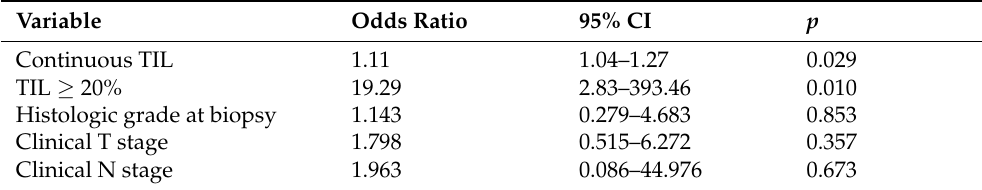
Table 2. Logistic regression analysis for the positive conversion of PD-L1 in the surgical specimen ( n = 32).